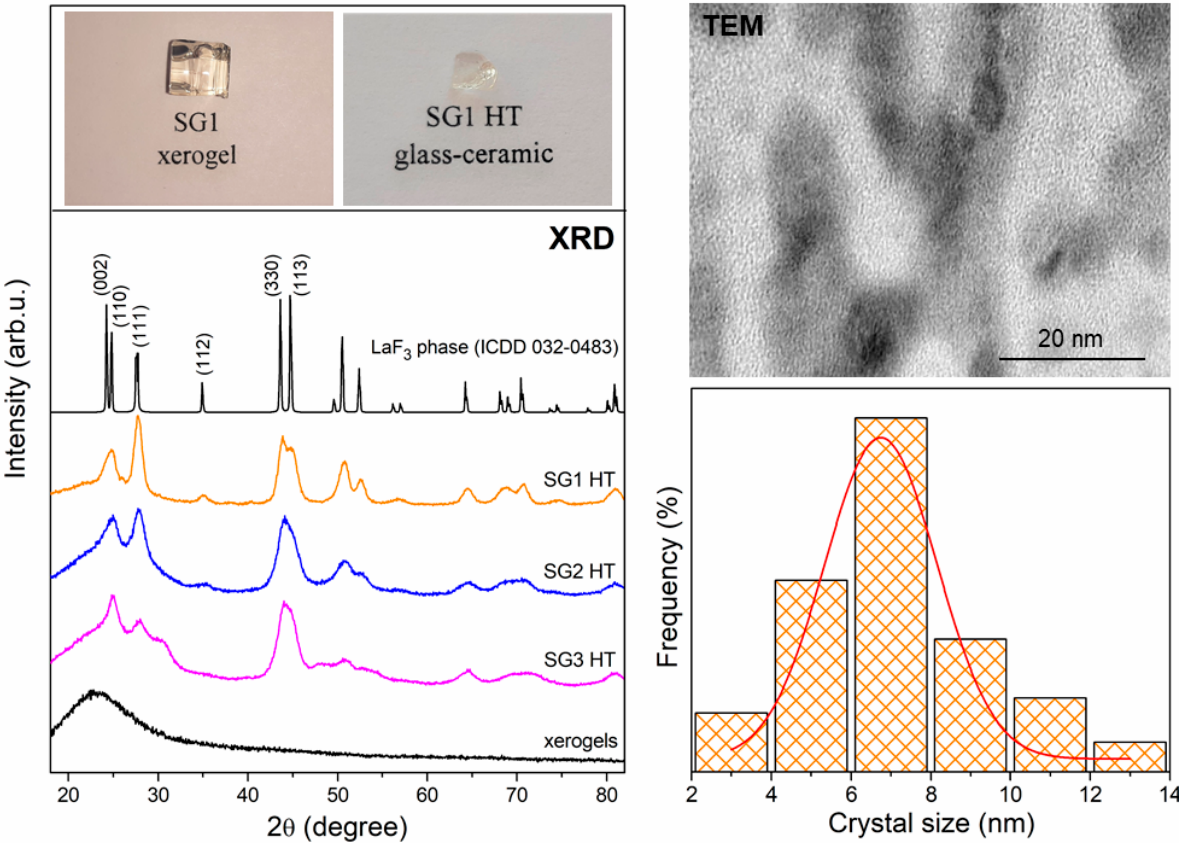
Figure 4. XRD patterns for fabricated xerogels and glass–ceramics. The photographic images of the SG1 xerogel and SG1 HT glass–ceramic, and the TEM image with crystal size distribution for the SG1 HT sample, are also shown.